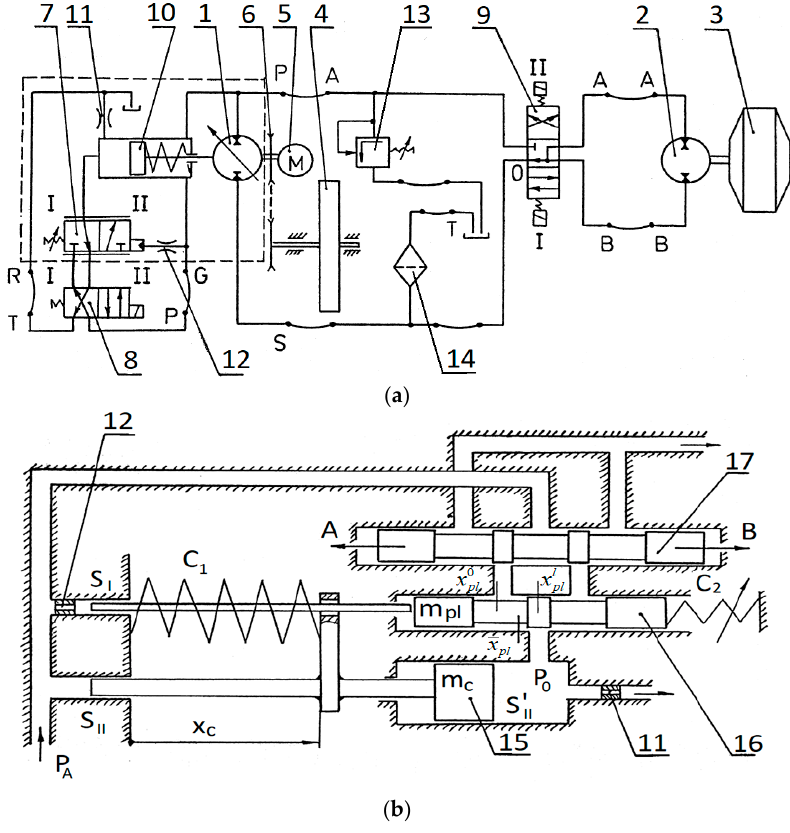
Figure 7. Proposed schemes of the test stand. ( a ) Hydraulic scheme of the stand; and ( b ) hydro-mechanical scheme of the A7V pump control system.